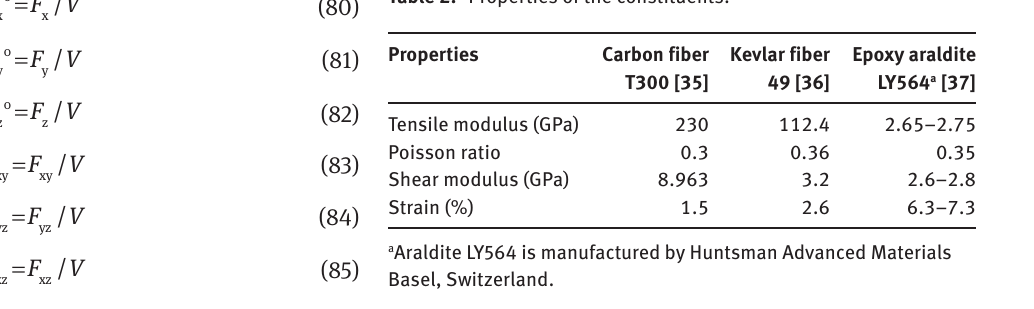
Table 2: Properties of the constituents.